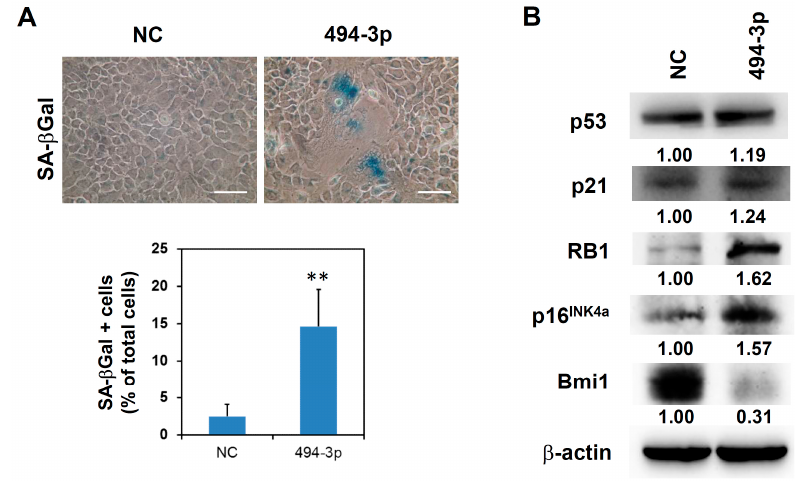
Figure 2. Overexpression of miR-494-3p induces cellular senescence in SAS cells. SAS cells were transfected with 100 nM miR-494-3p mimic (494-3p) or negative control mimic (NC). ( A ) Cellular senescence was determined by senescence-associated β -galactosidase (SA- β -Gal) staining at day 7 post-transfection. The quantification results were collected by 3 random fields of each miRNA mimic transfected samples. Scale bar: 50 μ m. **, p < 0.01; ( B ) The expression of p53, p21, p16 INK4a , retinoblastoma 1 (RB1), or B lymphoma Mo-MLV insertion region 1 homolog (Bmi1) was determined by Western blot at day 2 post-transfection. β -actin was used as an internal control. The inserted numbers indicated relative expression levels as comparison with NC group.